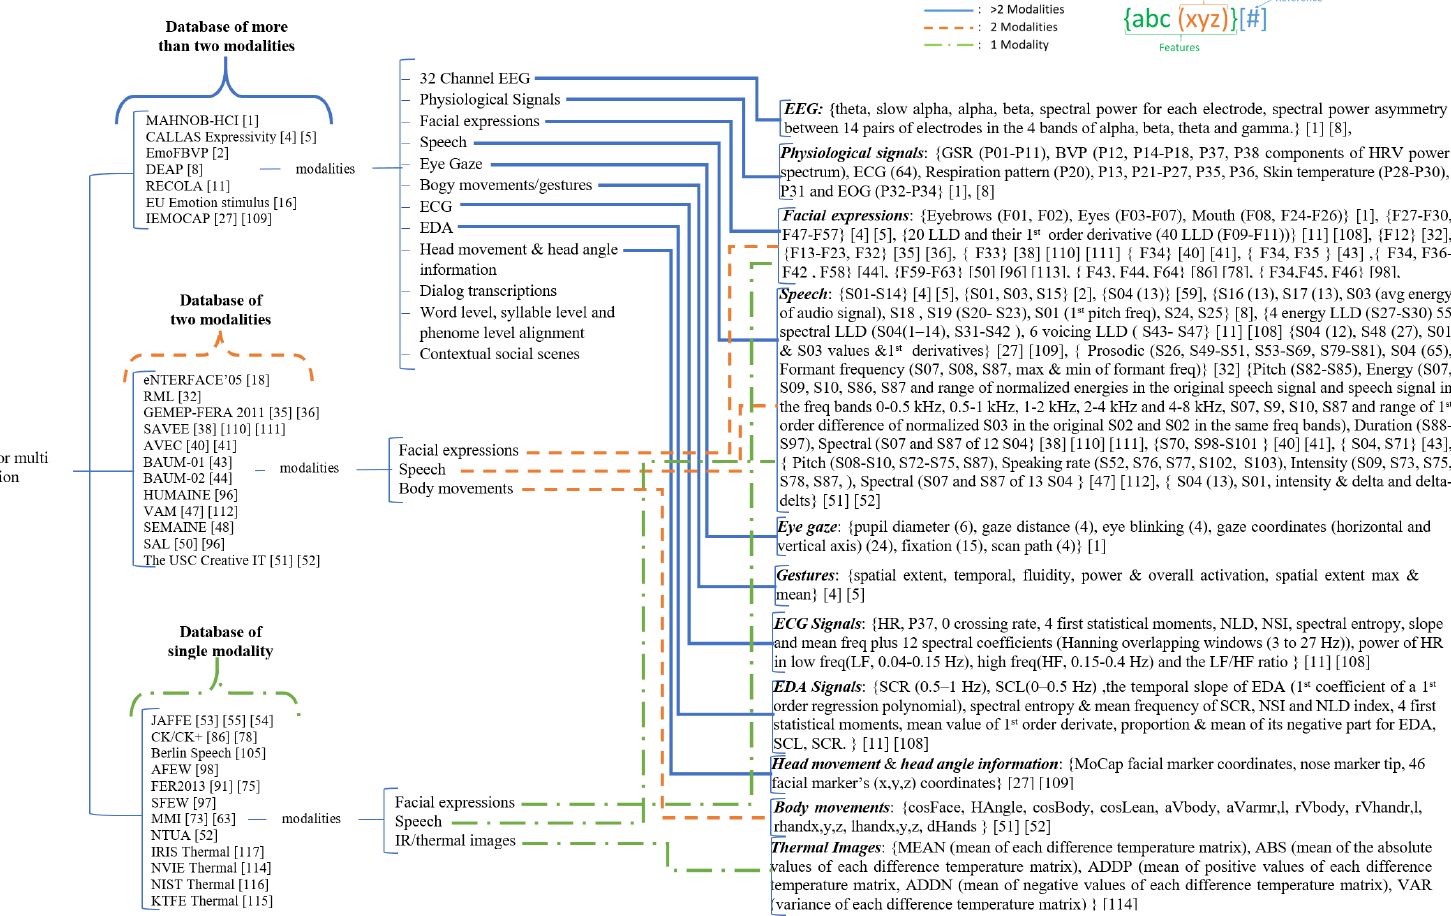
Figure 2. Taxonomy of the features applied in MER. Acronyms: BVP, blood volume pressure; NLD, normalized length density; NSI, non-stationary